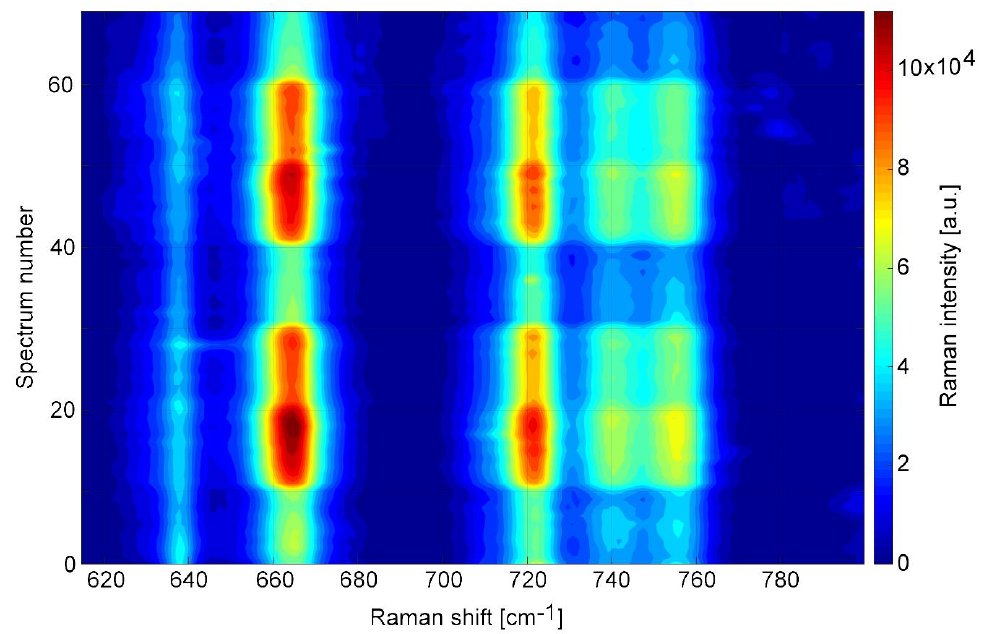
Figure 9. Spectral map of SK307 SERS signal of 10 mM TCP in cycling pH. Vertical axis represents time ordered spectra (30 s/spectrum). Horizontal axis represents the Raman shift. The intensity of the Raman signal is color-coded. Signal intensity is highest at pH 8.0 (red), decreases at pH 6.0 (orange) and is minimal at pH 4.0 (green-blue).